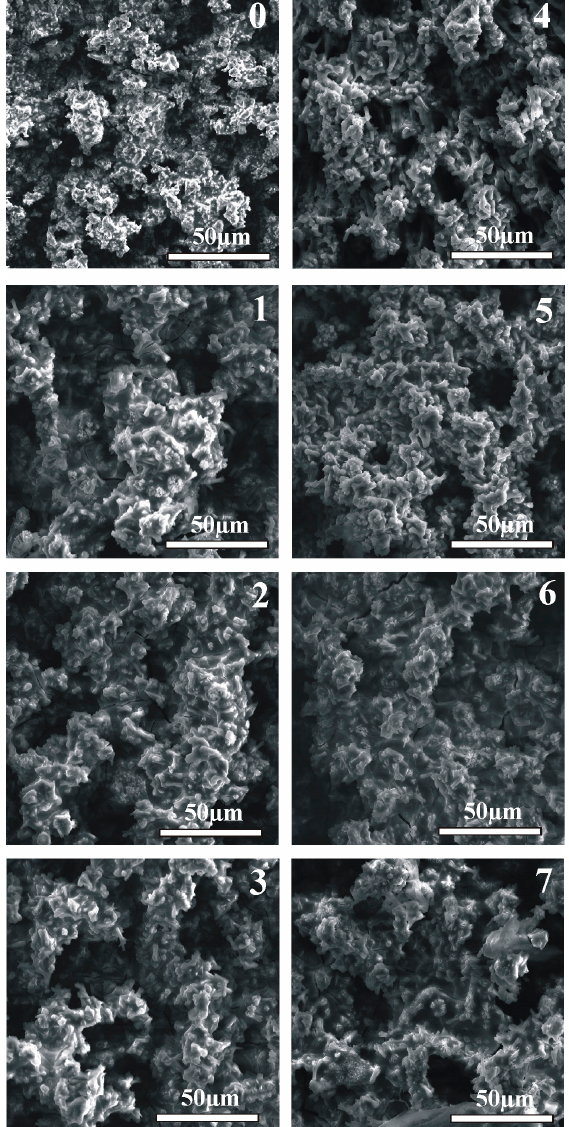
Figure 3. Surface view of the obtained hydrothermally treated hydroxyapatite surface layers on the substrates marked in accordance to sample composition. ( 0 ): Mg pure—Reference sample; ( 1 ): Mg4Y5.5Dy0.5Zr; ( 2 ): Mg4Y5.5Dy0.5Zr + 5%BG; ( 3 ): Mg4Y5.5Dy0.5Zr + 5%BG + 1%Ag; ( 4 ): Mg1Zn1Mn0.3Zr; ( 5 ): Mg1Zn1Mn0.3Zr + 5%HA; ( 6 ): Mg1Zn1Mn0.3Zr + 5%HA + 1%Ag; ( 7 ): Mg1Zn1Mn0.3Zr +